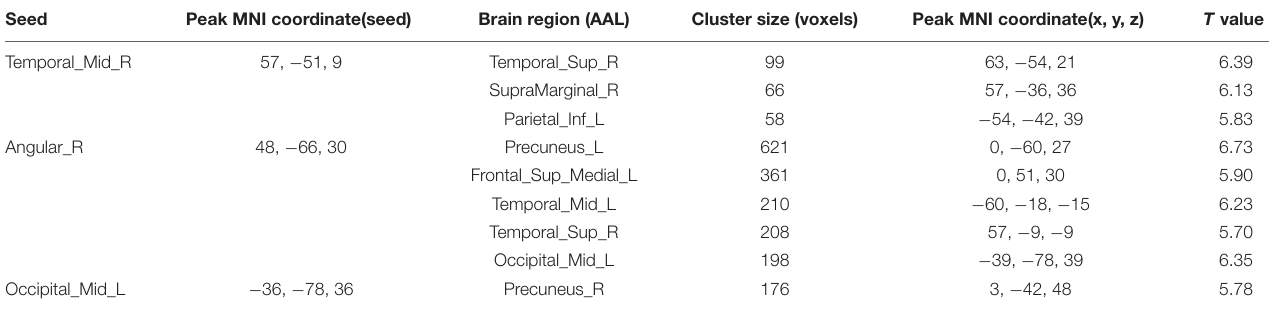
TABLE 4 | Regions with significant seed-based FC differences between mTBI and